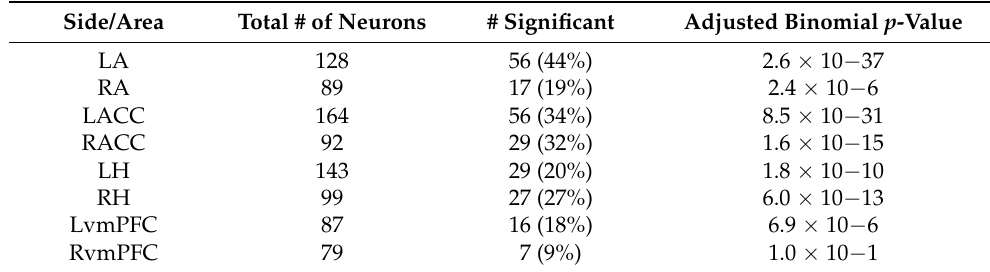
Table A4. Significant neuronal responses (relative to background firing) by side and brain area (SUA) among all subjects ( n = 13), as indicated by the changes from background test.